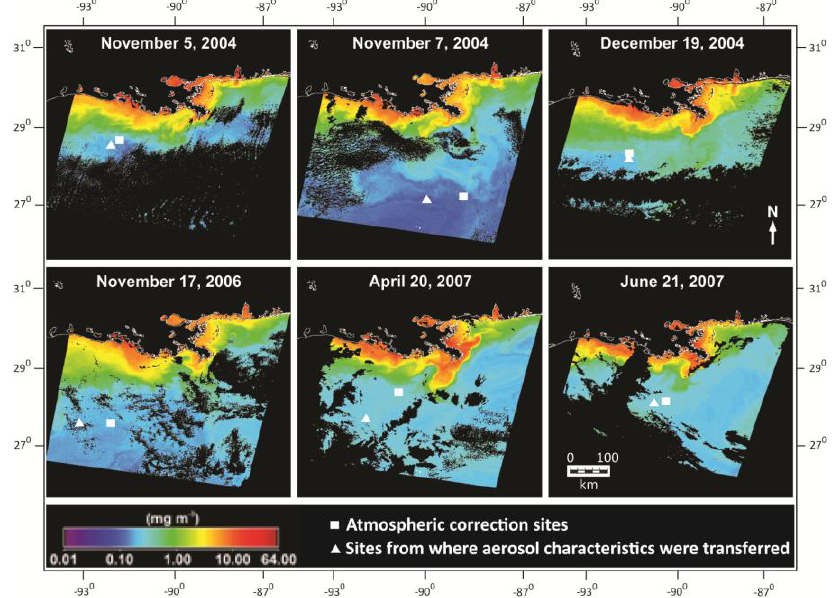
Figure 2. SeaDAS processed SeaWiFS chlorophyll a images of northern Gulf of Mexico. The sites represented by filled squares are the clear water locations, where atmospheric correction was performed. The sites represented by filled triangles are the locations from where aerosol characteristics were transferred to the atmospheric correction